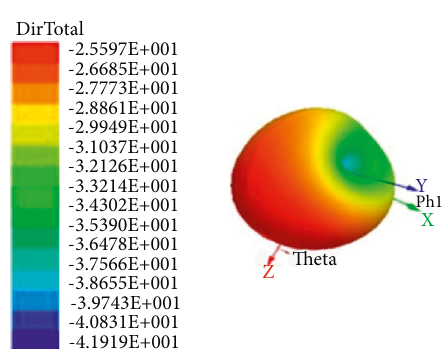
Figure 9: Gain of circular patch